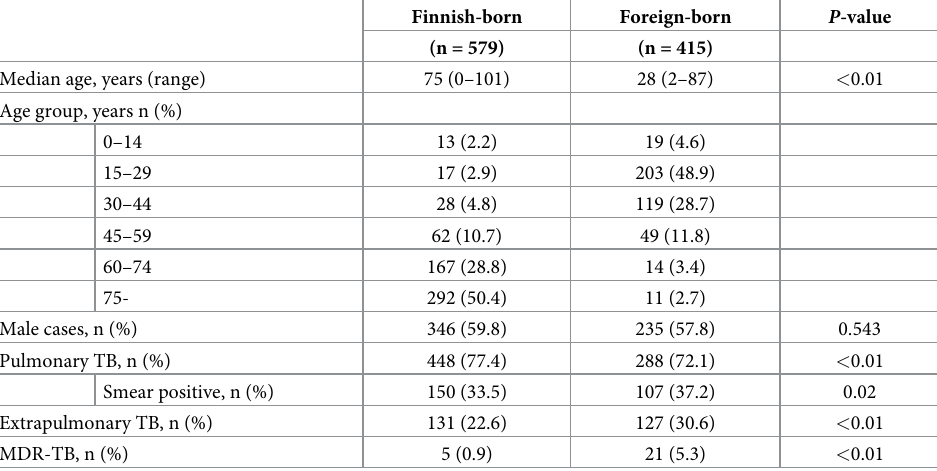
Table 1. Characteristics of Finnish-born and foreign-born TB cases in Finland, 2014–2017.